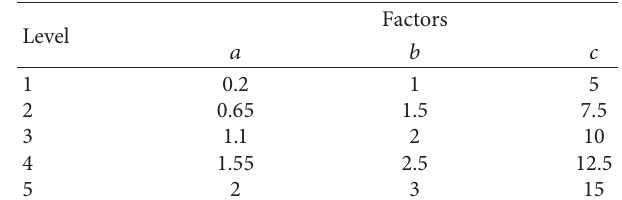
Table 2: Factors and levels.